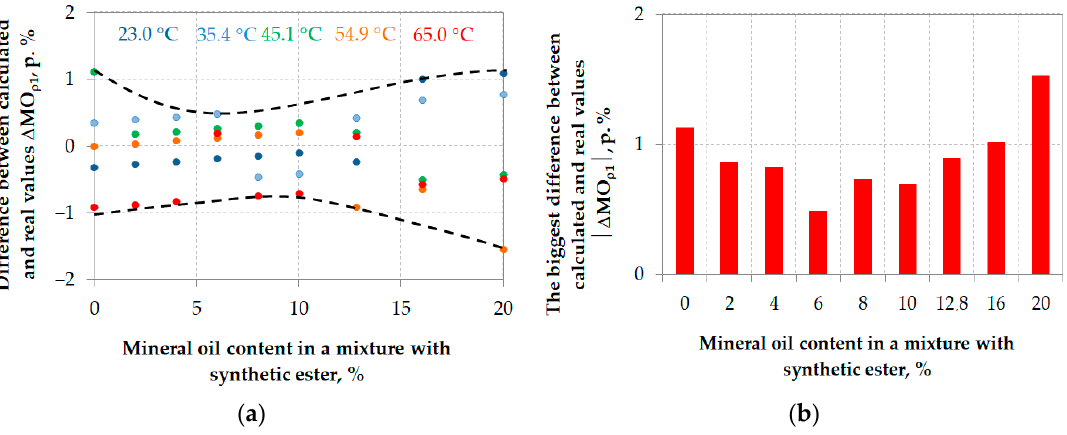
Figure 4. Parameters a ( a ) and b ( b ) depending on temperature (measurements of mixture density).